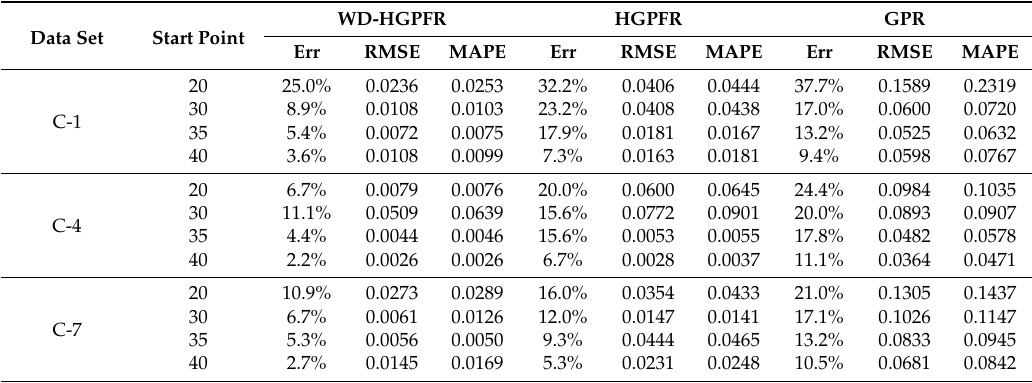
Table 1. Prognostic results and evaluation criteria using different methods with different lengths of training